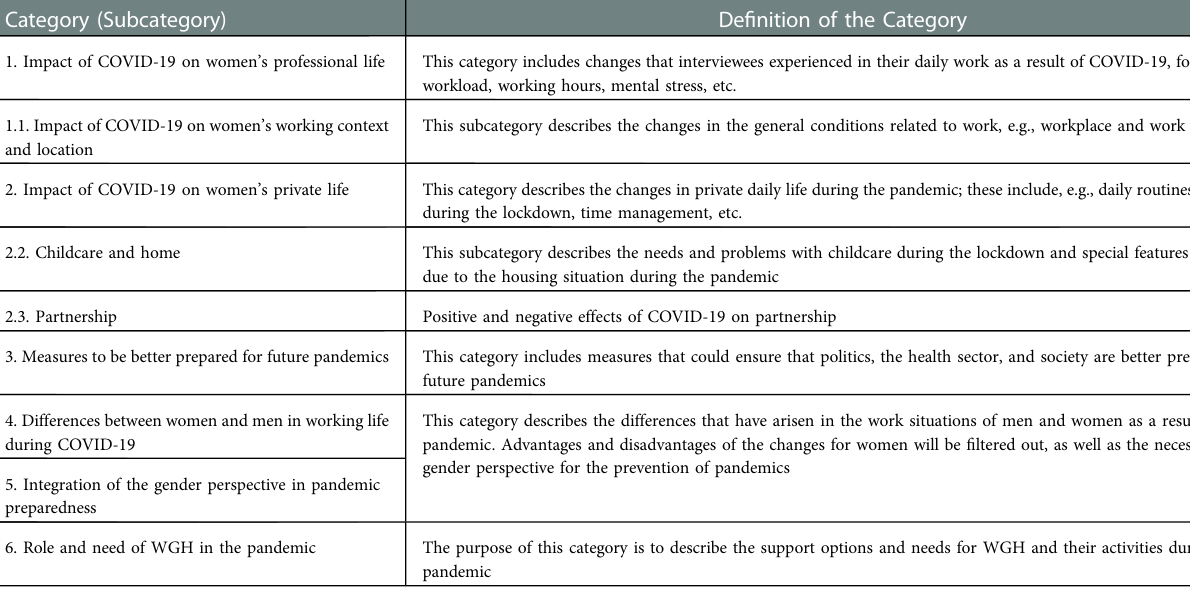
TABLE 3 De fi nition of the single categories emerged from the qualitative analysis. Category